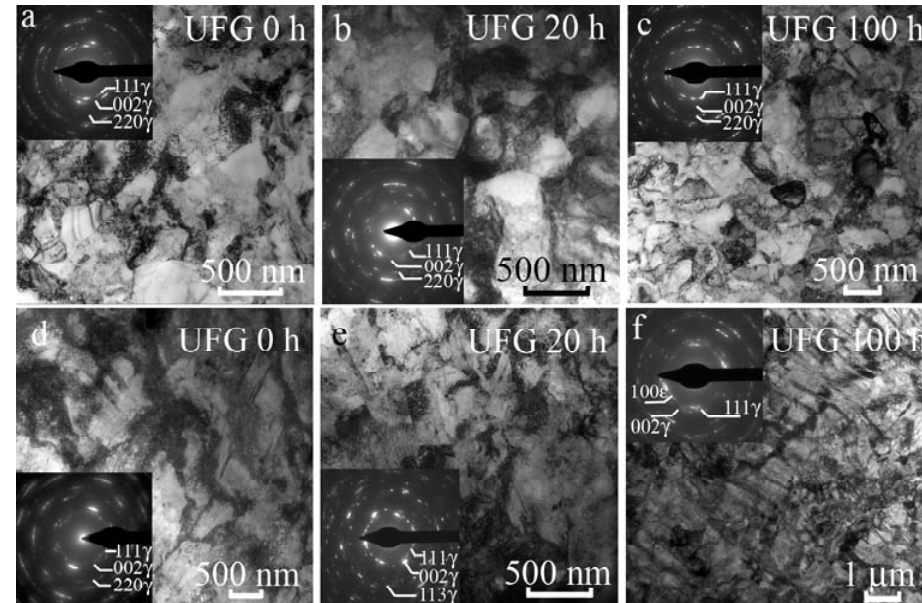
Fig. 7. The characteristic TEM bright-field micrographs and SAED patterns (inserted) in UFG-CrNiTi steel depending on hydrogen-charging regime and strain: a, d – hydrogen-free specimen; b, e – hydrogen-charged for 20 hours; c, f – hydrogen-charged for 100 hours; a, b, c – specimens after ABC-pressing; d, e, f – specimens after ABC-pressing and tension to fracture. SAED patterns is obtained from the area of 27  m 2 . TEM images correspond to surface hydrogen-saturated